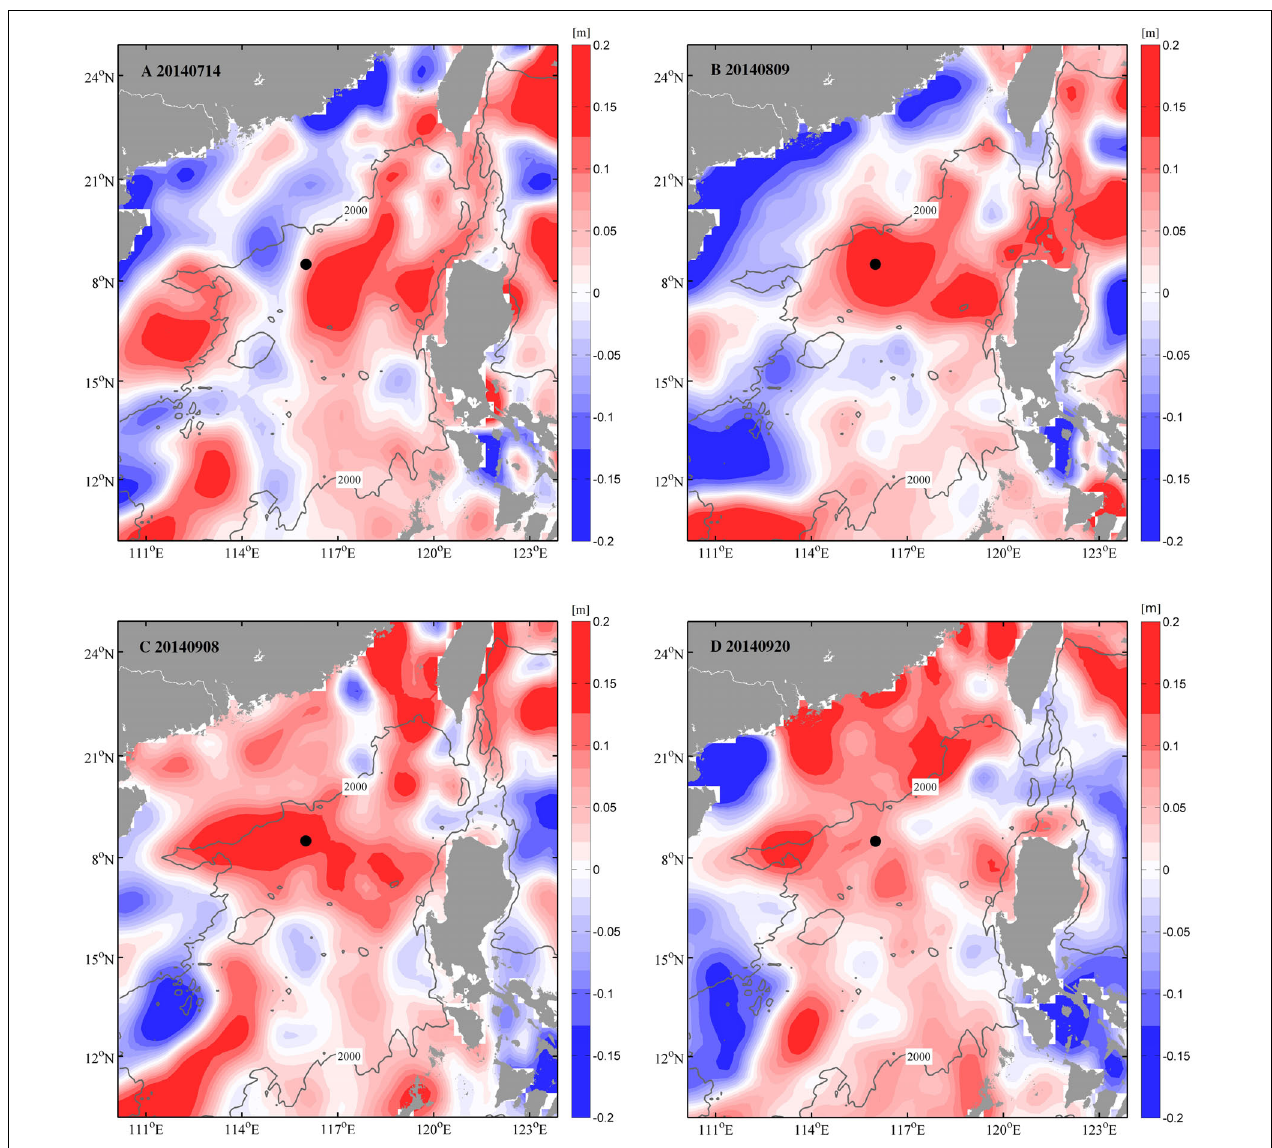
FIGURE 7 | Satellite images of daily sea surface height anomaly (SSHA, m) in northern SCS from AVISO product on (A) July 14, 2014, (B) August 09, 2014, (C) September 08, 2014, and (D) September 20, 2014, exhibiting anticyclonic eddy activity during summer period of 2014 in study area. Black dots on map represented 1/4 ◦ × 1/4 ◦ area around station SCS-N. Gray line with label 2,000 indicates water isobaths of 2,000